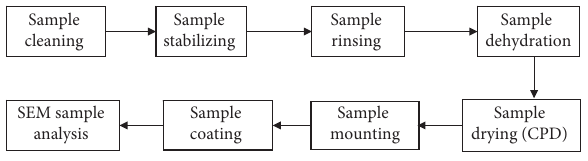
2 O [H 2 O]. (b) OPC-BM [H 2 O]. (c) OPC-H 2 O [BM]. (d) OPC-BM [BM].